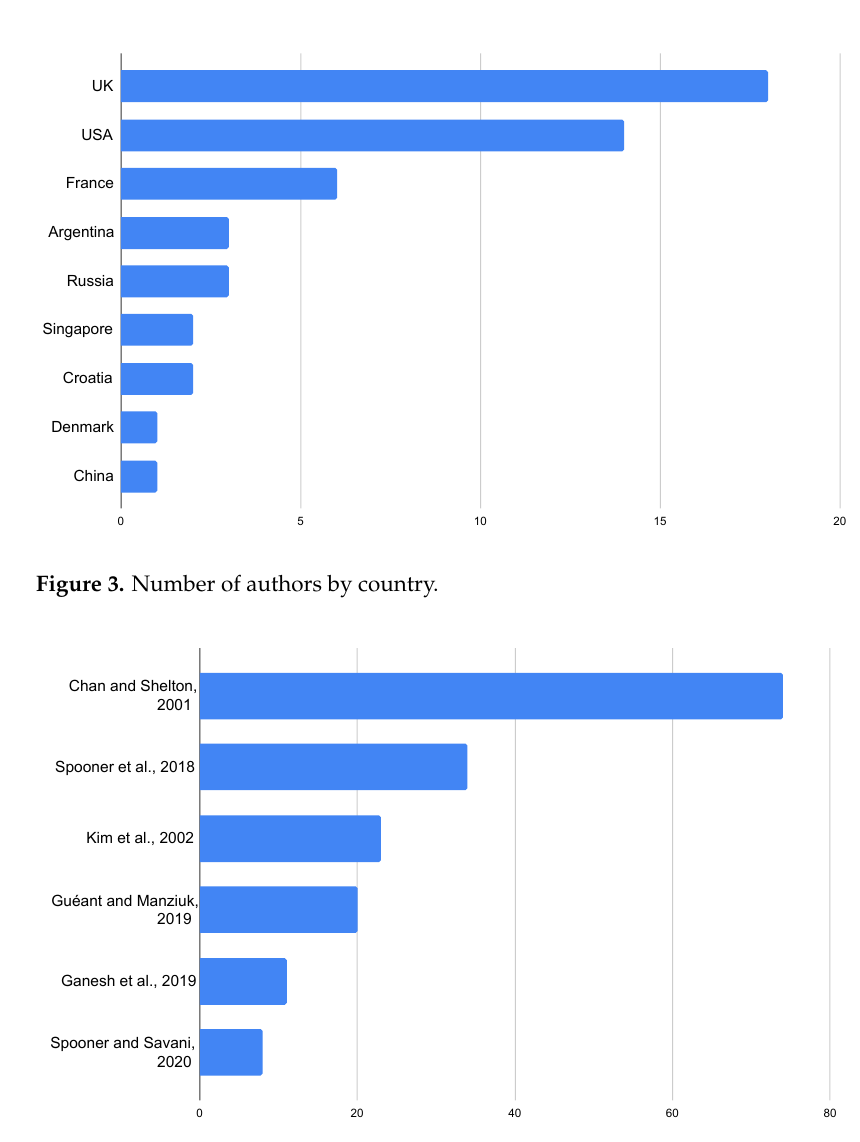
Figure 4. Number of citations by